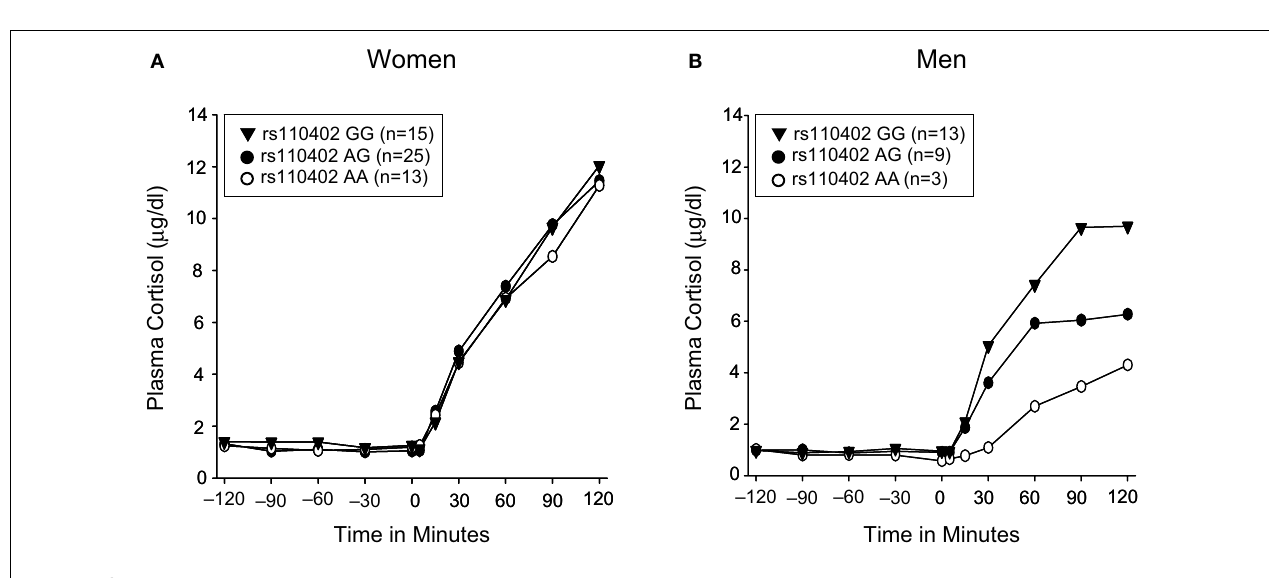
ANOVA only revealed a signifi cant main effect for the time factor ( F = 68.486, p < 0.001), indicating similar increases in cortisol 10, 500 concentrations in all groups. (B) In men, repeated measures ANOVA revealed a signifi cant interaction of time by genotype ( F = 2.225, p = 0.017), 10,230 indicating decreased response in men carrying the A allele compared to men homozygous